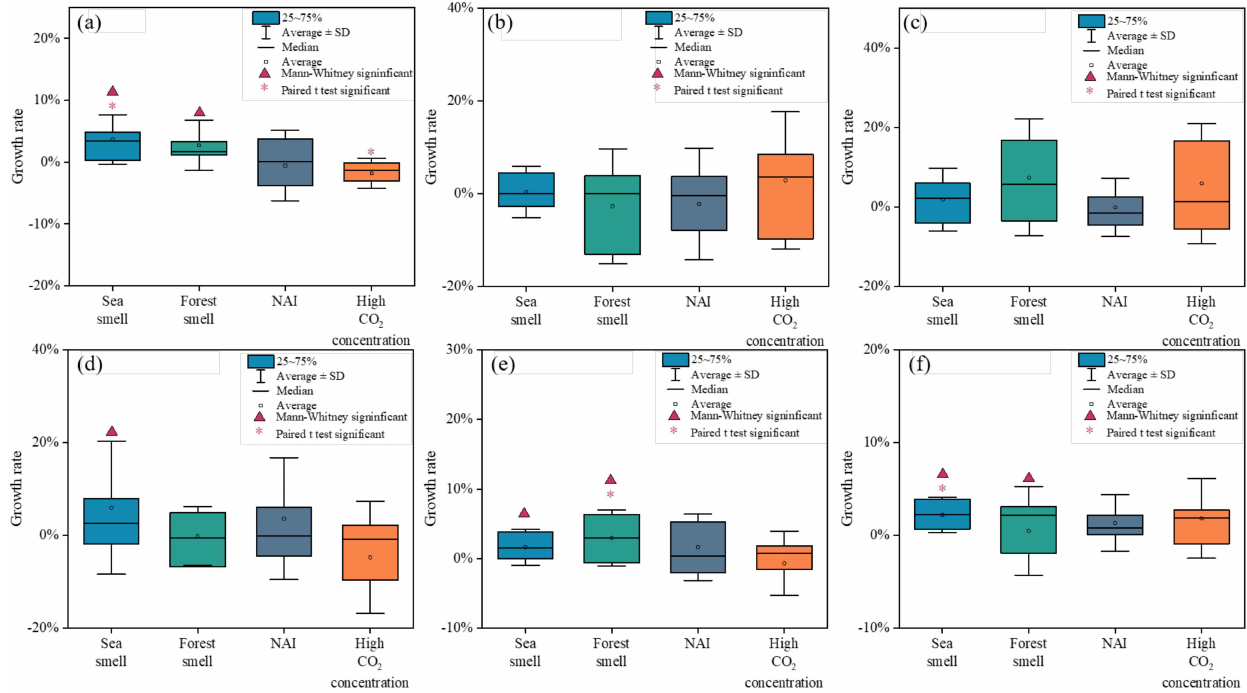
Figure 11. The performance of cognitive tests on Mind Quantified platform in the four scenarios, ( a ) 2 back; ( b ) forward digit span; ( c ) simple reaction time; ( d ) choice reaction time; ( e ) color word; and ( f ) visual